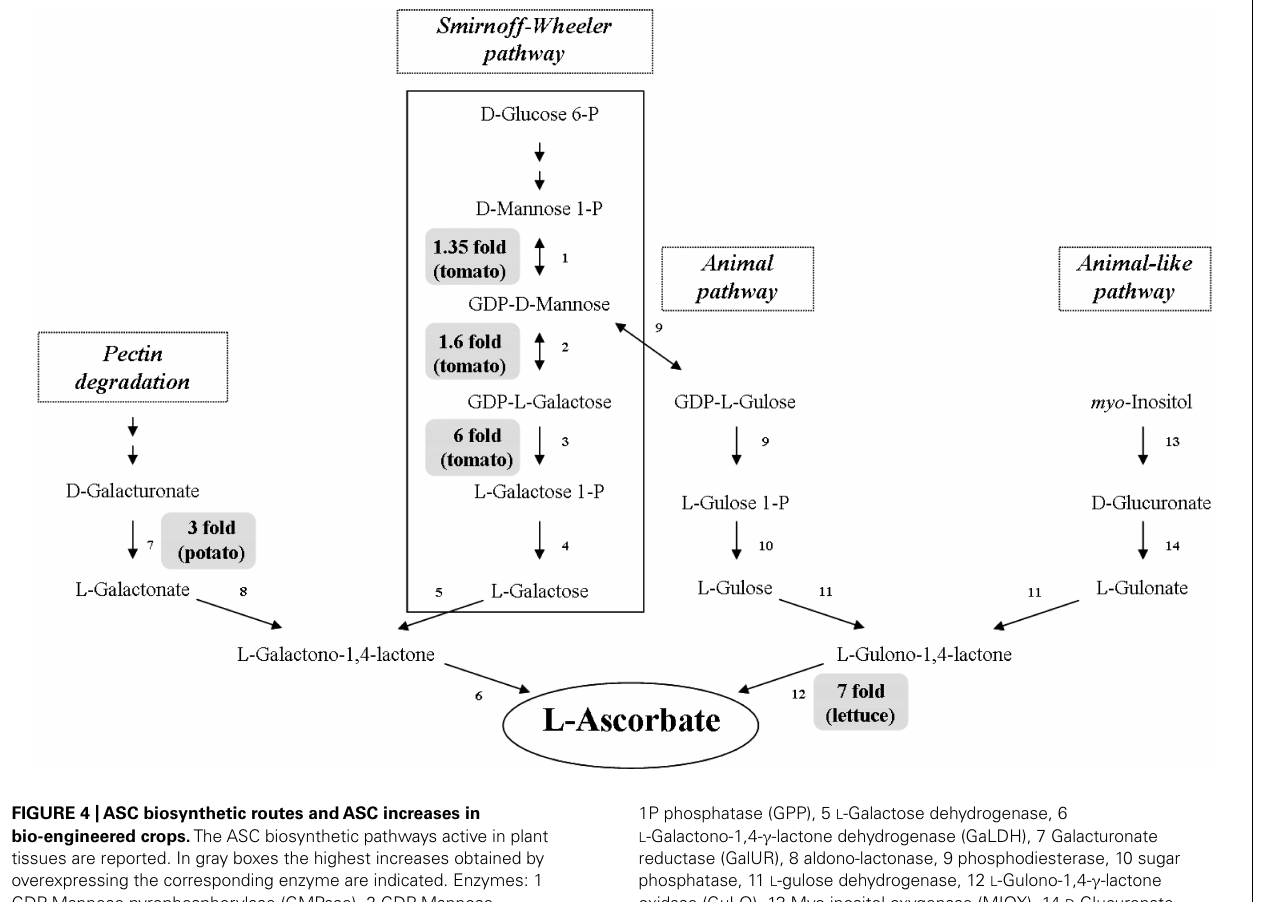
1P phosphatase (GPP), 5 L -Galactose dehydrogenase, 6 L -Galactono-1,4- γ -lactone dehydrogenase (GaLDH), 7 Galacturonate reductase (GalUR), 8 aldono-lactonase, 9 phosphodiesterase, 10 sugar phosphatase, 11 L -gulose dehydrogenase, 12 L -Gulono-1,4- γ -lactone oxidase (GuLO), 13 Myo-inositol oxygenase (MIOX), 14 D -Glucuronate